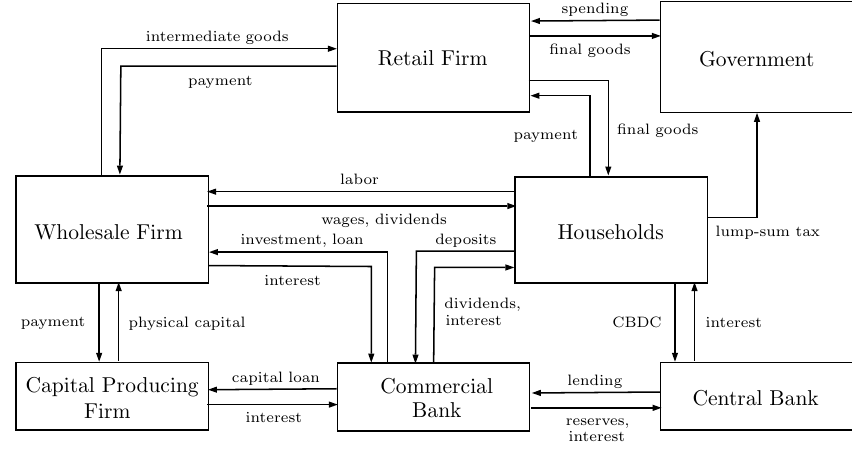
Figure 1. The model